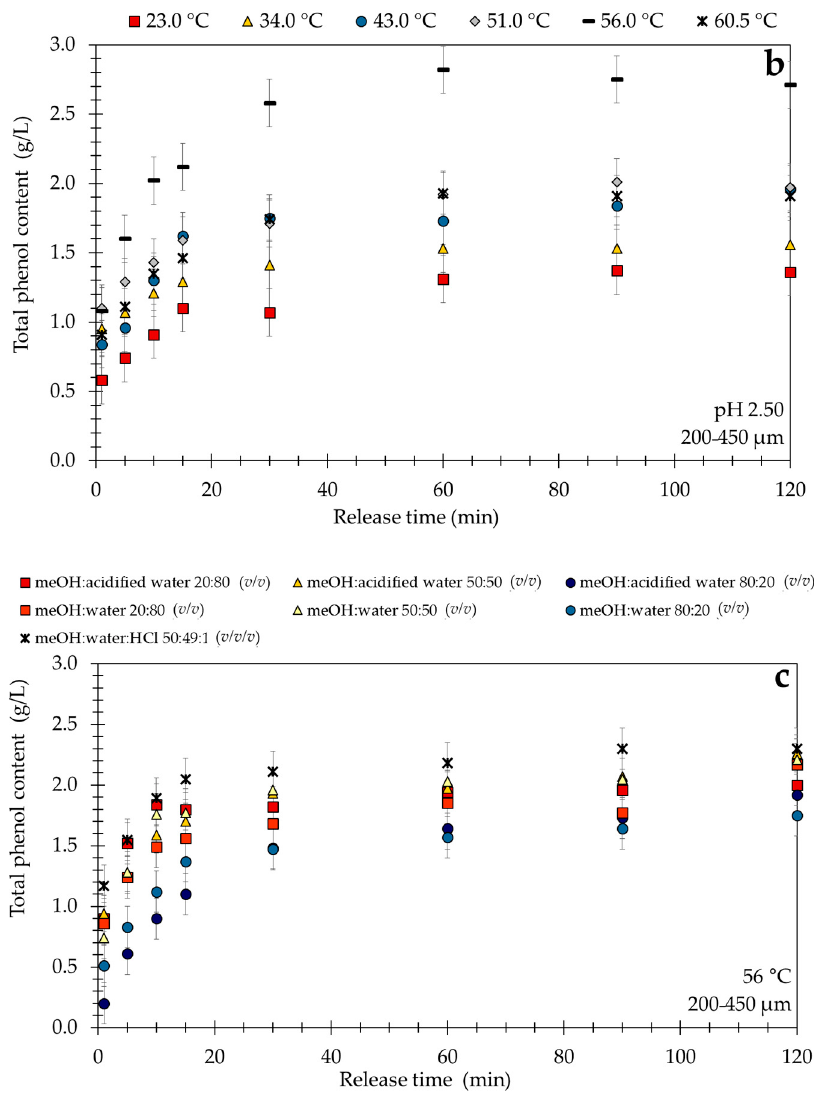
Figure 2. Extraction kinetics using laboratory robot by variation of pH value ( a ), temperature ( b ), and solvent ( c ) with size small (SS) plant material.